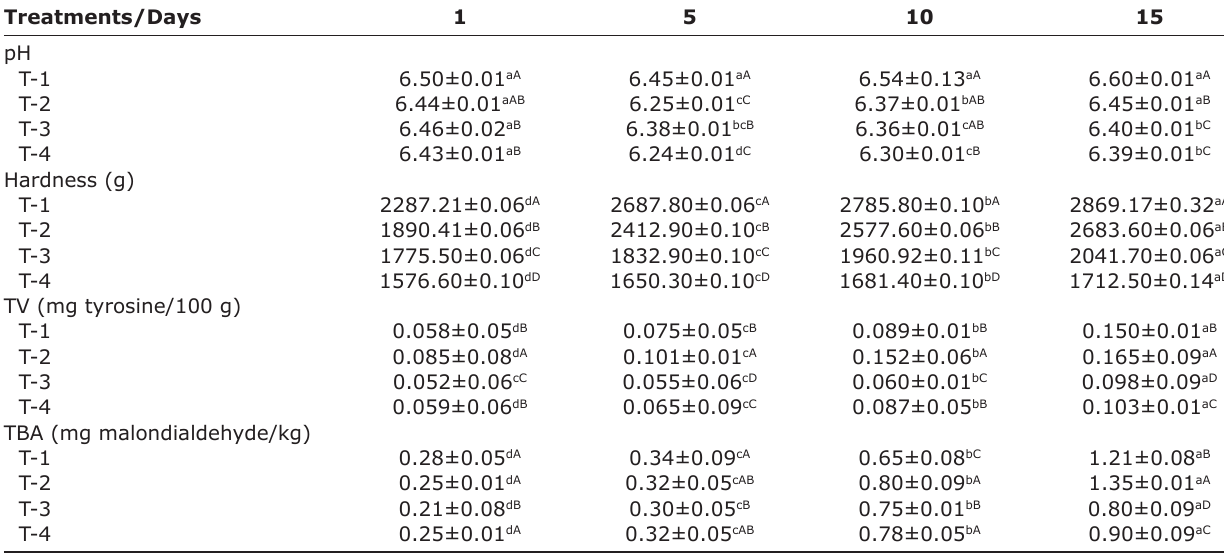
Table-2: Physico-chemical properties of Vawksa rep (smoked pork product) stored under vacuum packaging conditions at 4°C±1°C.